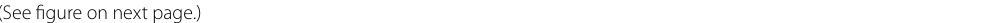
Fig. 2 Inhibition of platelet activation suppressed reactive EGCs. a , b Flow cytometric dot blots of 2-color fluorescence staining of mice platelets with anti-CD40L followed by anti-CD41-FITC. The numbers at corners indicated the percentage of CD41 and CD40L double positive population (n 4). c Serum sCD40L levels (n 6). d – f Immunofluorescence staining analysis of GFAP (green) and CD40 (red), Scale bar = = g – i Western blot analysis of GFAP and CD40 expression (n 6). The data are presented as the mean = **** P